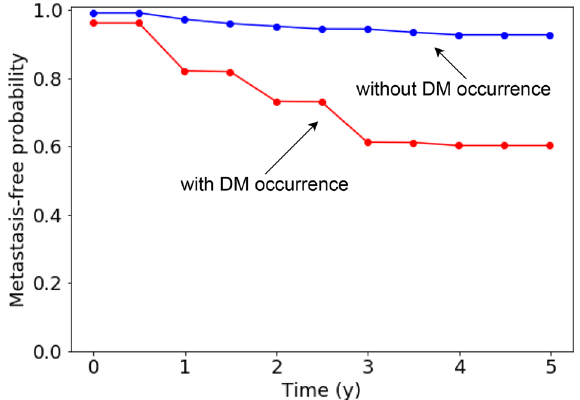
Figure 2. Time-to-event network output. The DM-free probability curves shown are taken from two exemplary patients of the CRO testing cohort using the 3D-CNN as prognostic model. Note that the network output is at pre-defined discrete time points, the lines being drawn for visualisation purposes.